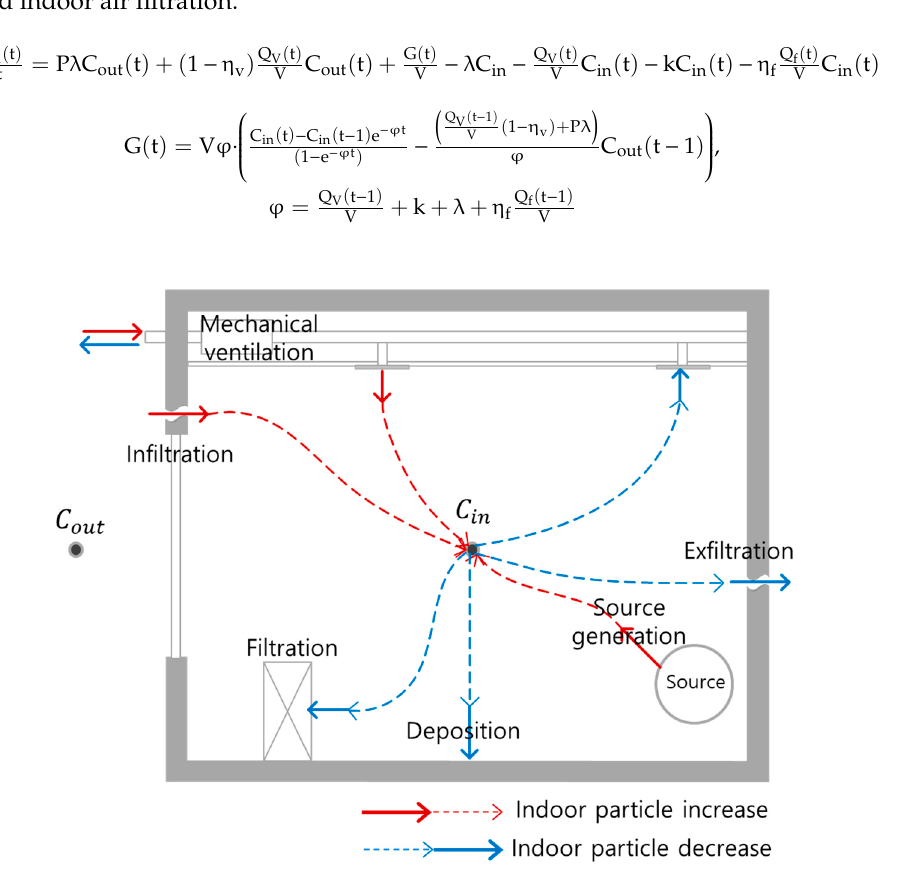
Figure 2. Particle matter (PM) concentration mechanism in a space with a mechanical ventilation system and portable filtration system.